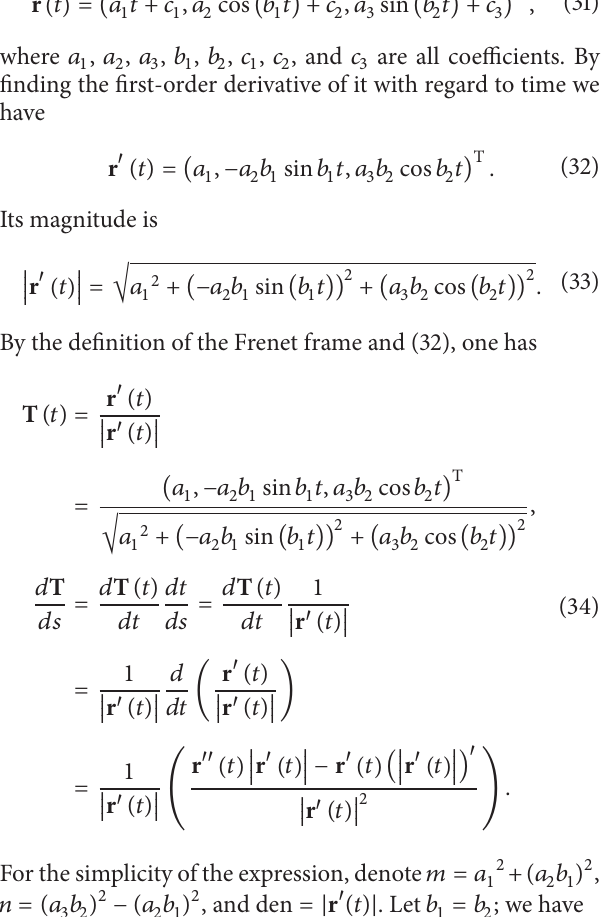
Figure 2: The planform and the actuators distribution of the flying- wing